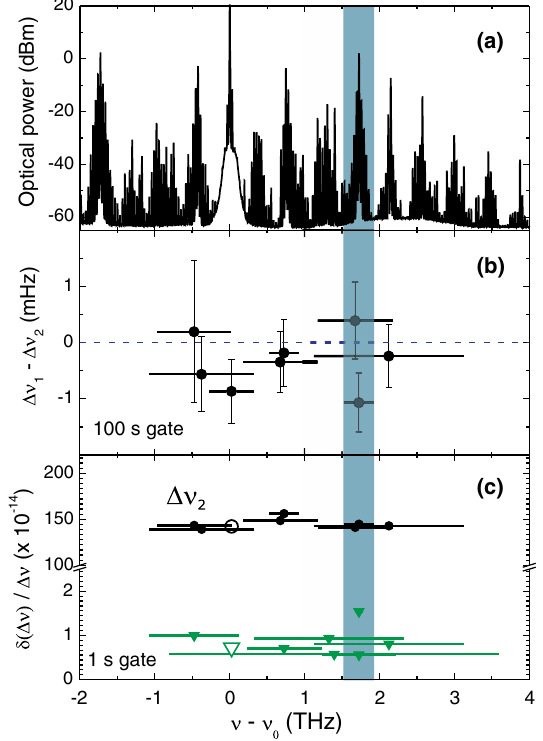
FIG. 4. Line-spacing equidistance and stability for different spectral slices of the comb. (a) Microcomb optical spectrum prior to filtering. about the pump laser frequency (cid:2) 0 (cid:2) (cid:1) (cid:2) ) (b) Measurements of the frequency difference ( (cid:1) (cid:2) 1 2 between the whole comb and a spectral slice. The horizontal bars indicate the frequency range of each measurement, which is highlighted by the shaded region for one point. (c) For different spectral slices, the points show the 1-s Allan deviation of (cid:1) (cid:2) 2 measured against maser 2, and the triangles characterize residual and (cid:1) (cid:2) measured against maser 1. fluctuations between (cid:1) (cid:2) 1 2 For the open circle and open triangle data points, only a 0.3-THz is blocked. range about (cid:2) 0